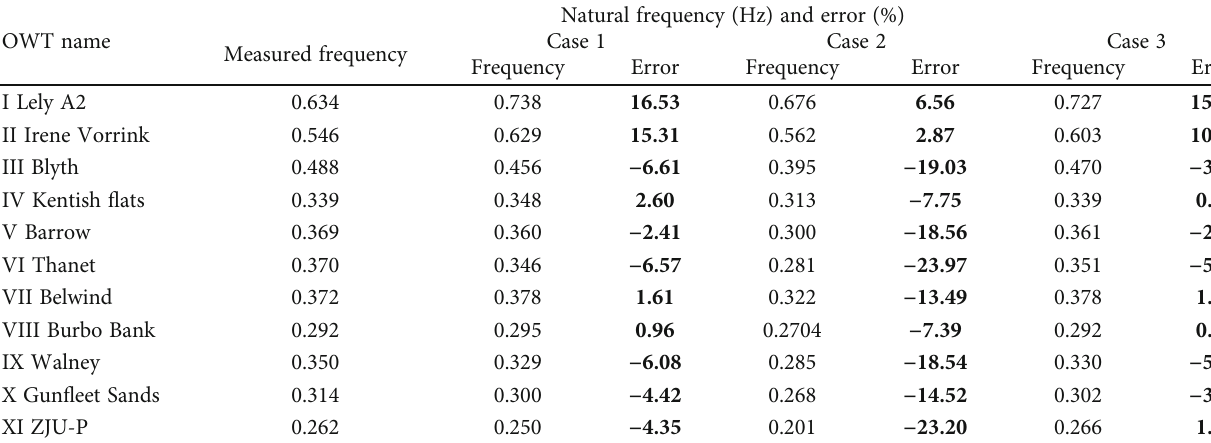
Table 3: Natural frequencies and